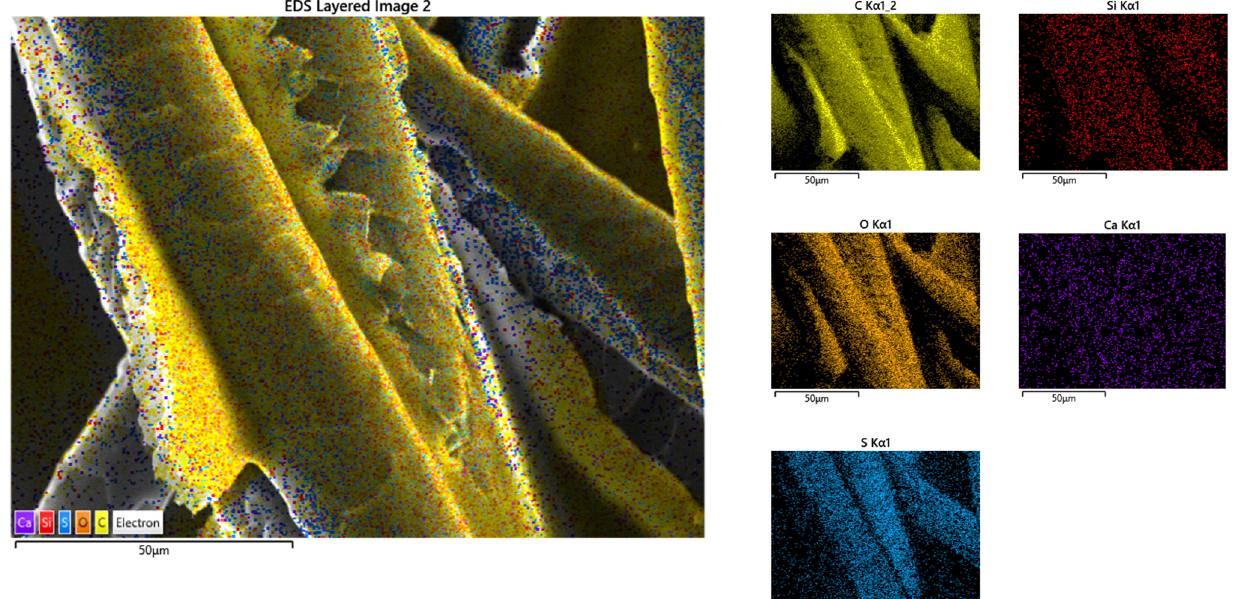
Figure 15. EDX elemental map distribution image of sample P13, magnification ×1000.